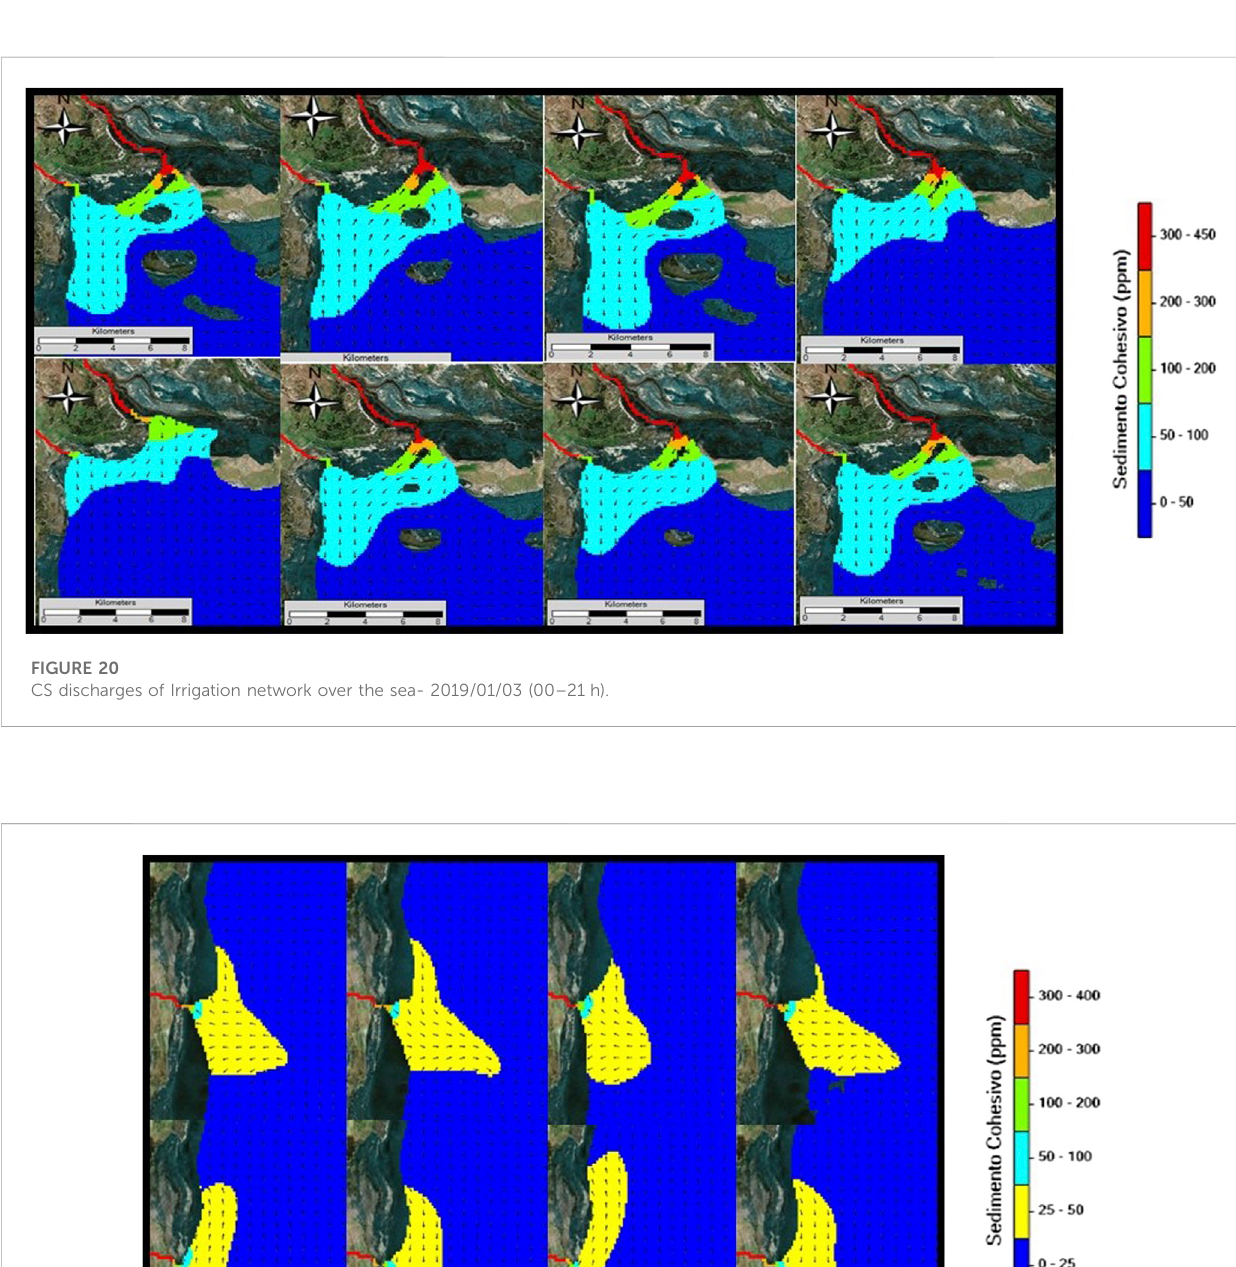
drainage network has a similar behavior, with higher fl ows during peak irrigation periods (spring-summer), when it is necessary due to the higher production in the basin (Figure 15). The sediment concentrations of irrigation network are between 80 and 400 ppm throughout the year, showing its independence from rain and runoff (the fl ow rate does not present signi fi cant variations, the high concentration can be due to the work carried out on the